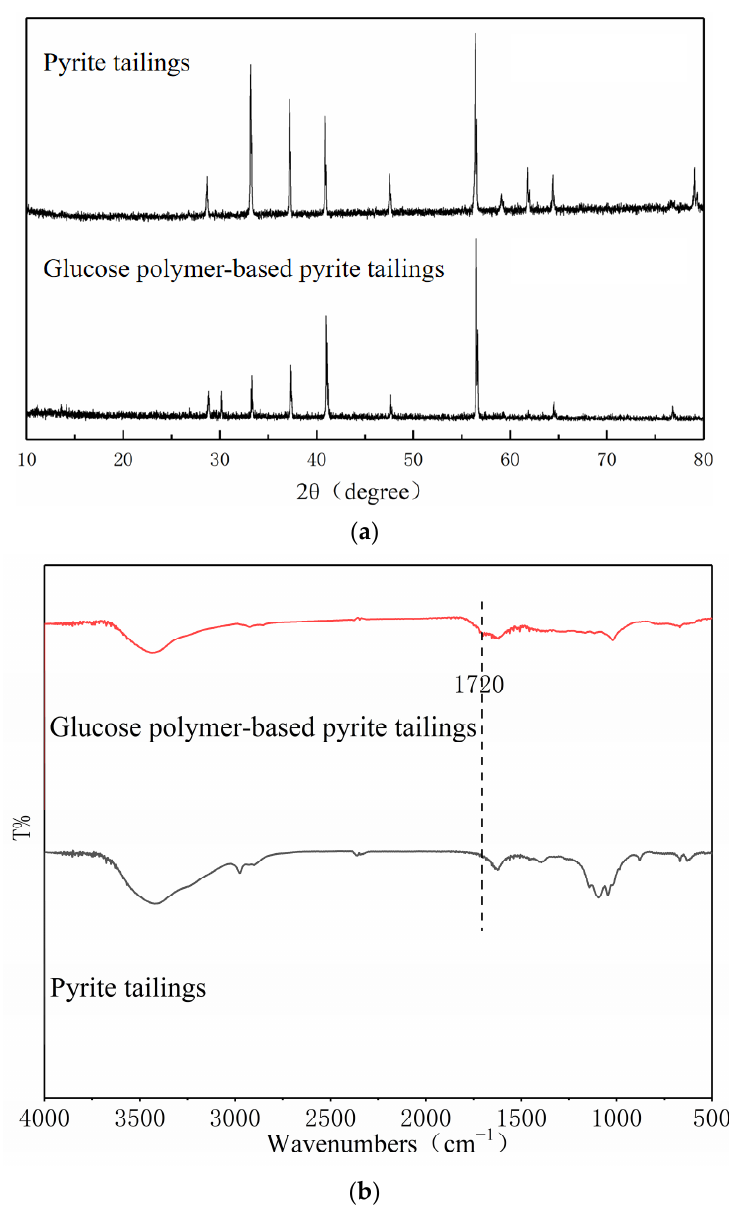
Figure 2. XRD pattern of pyrite tailings before and after coating ( a ). FTIR spectra of pyrite tailings before and after coating ( b ).